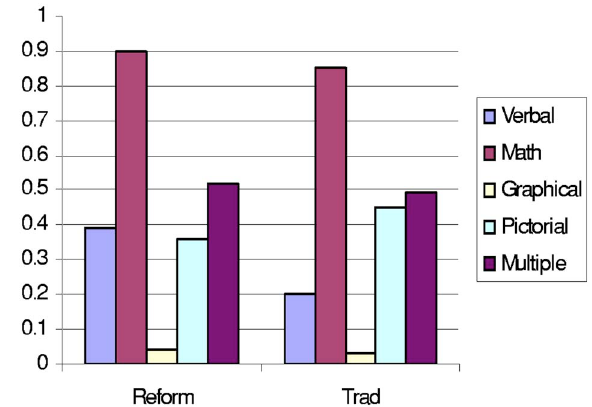
FIG. 6. (cid:1) Color (cid:2) Distrubution of representations used in the long- format homeworks in the two Physics 202 courses studied here (cid:1) reform and traditional (cid:2) . Also includes fraction of the homework assignments that required explicit use of